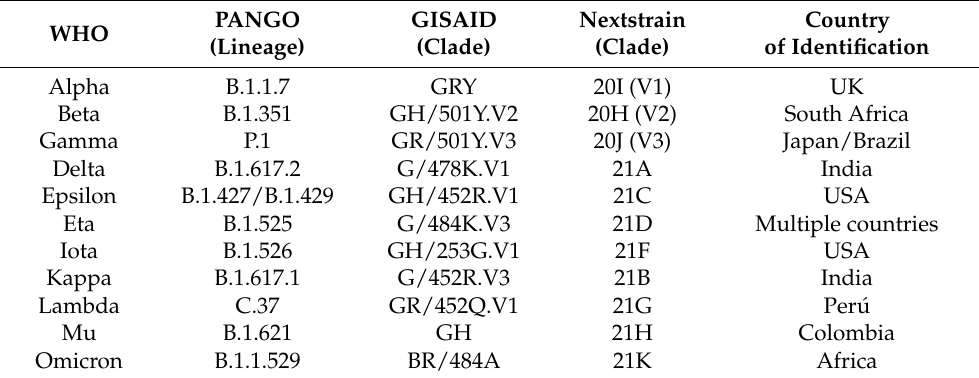
Table 1. Classification of SARS-CoV-2 viral variants identified worldwide. PANGO WHO (Lineage)